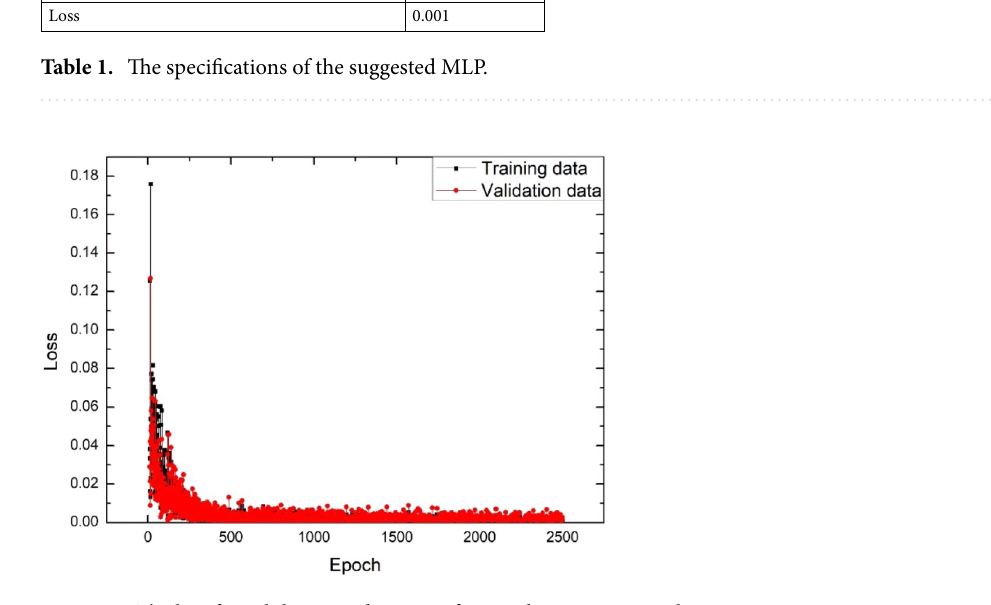
Figure 3. The loss for validation and training for 100 data in 2500